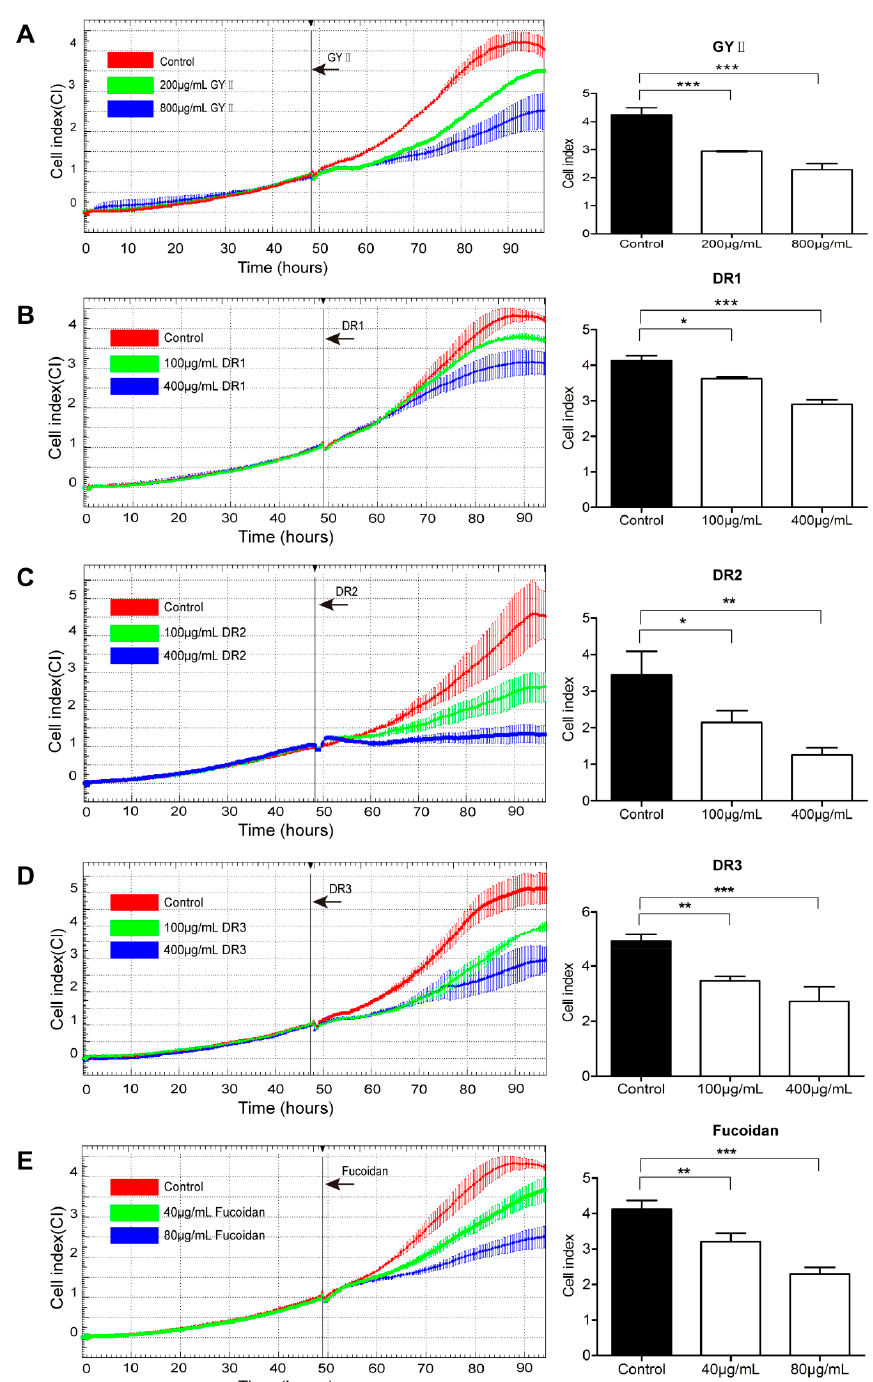
Figure 4. GYII and its decomposed recipes inhibited murine 4T1 cell proliferation. Time-dependent proliferation and cytotoxicity profiles of 4T1 cells were detected by real-time cell analysis (RTCA). GYII ( A ); DR1 ( B ); DR2 ( C ); DR3 ( D ); and fucoidan ( E ) diluted in medium were added to the cells when they reached the exponential growth phase (48 h after seeding). The cell index was monitored for 96 h. The cell index values from three independent experiments are presented in the right panels. (* p < 0.05, ** p < 0.01, *** p < 0.0001).